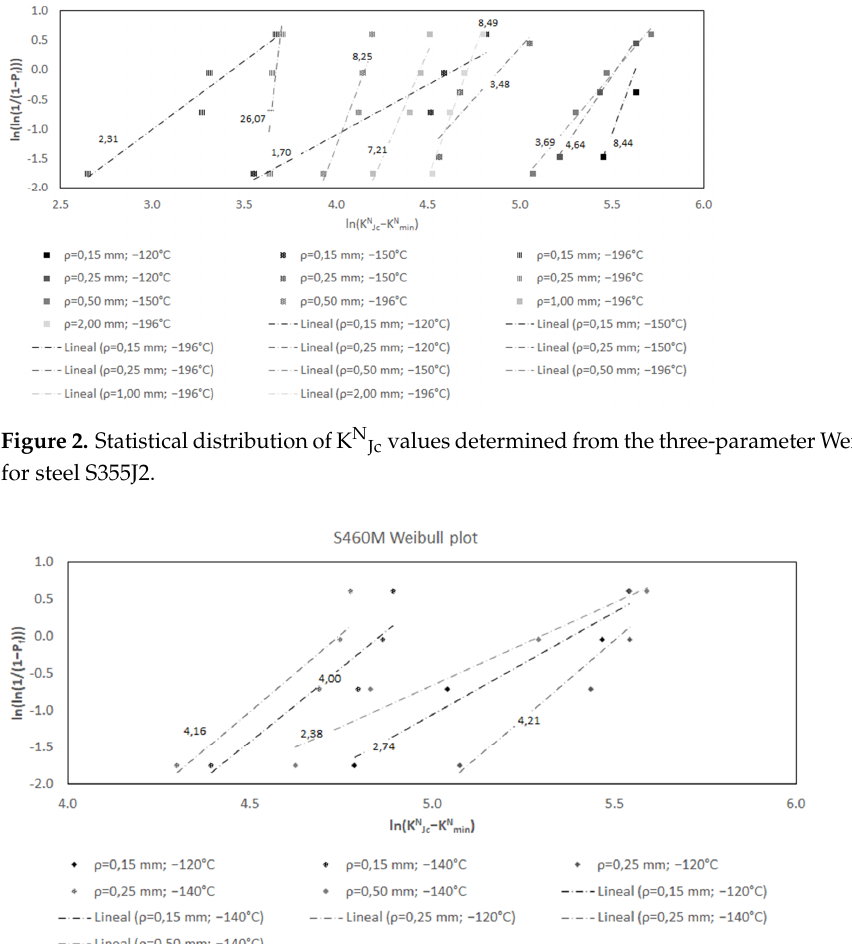
Figure 3. Statistical distribution of K N Jc values determined from the three-parameter Weibull function for steel S460M.